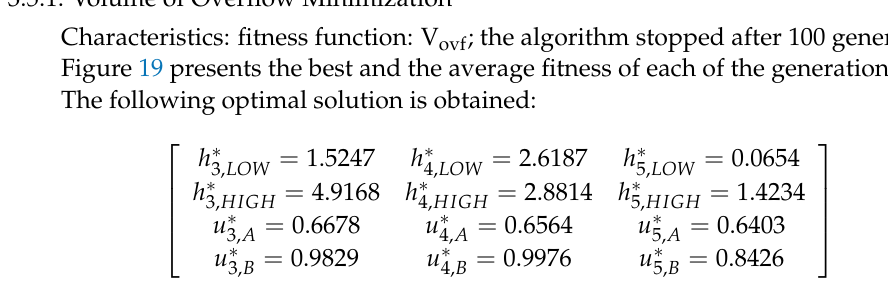
Figure 18. Strategy #4 chromosomal structure.